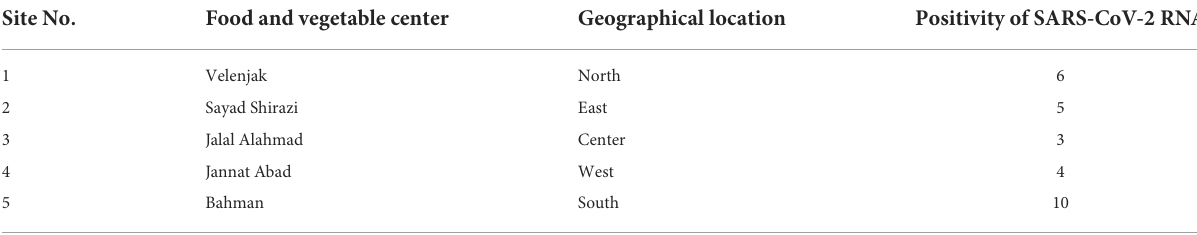
TABLE 3 Geographical prevalence of SARS-CoV-2 RNA in fresh produce from food and vegetable center of Tehran. Site No.